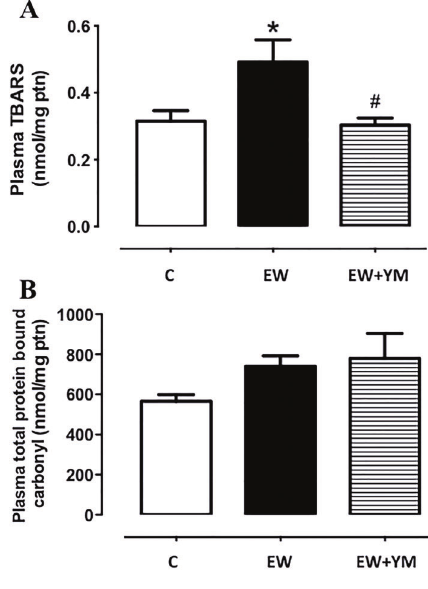
Figure 5. Yerba mate treatment prevented the increase of plasma thiobarbituric acid reactive substances (TBARS) levels caused by early weaning but early weaning and yerba mate treatment did not change plasma protein bound carbonyl. A , TBARS content and B , total protein bound carbonyl in the plasma at postnatal day 180 of adult rats that were normally breastfed for 21 days (C), early-weaned (EW), or EW that received yerba mate for 30 days (EW + YM). Data are reported as means ± SE of 10 rats per group. *P o 0.05 vs C; # P o 0.05 vs EW (ANOVA and Newman-Keuls multiple comparison test).